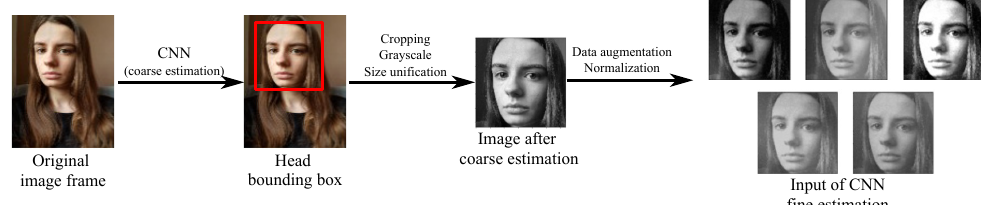
Figure 3. Data flow of CNN valid image dataset preparation. The original image data are fed to a coarse estimation, which results in the square head bounding box. The cropped image is unified in size, normalized, and preprocessed for training purposes.